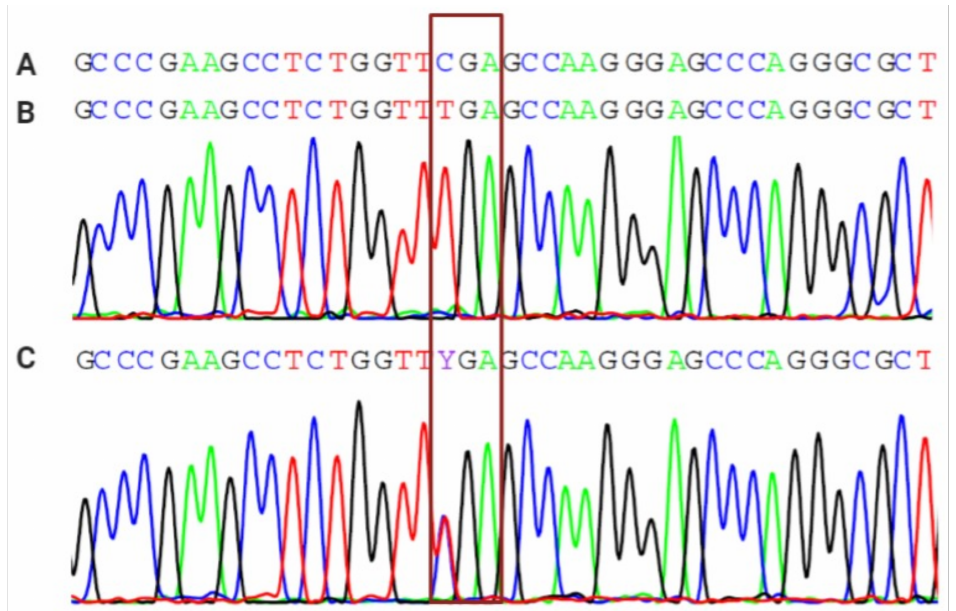
Figure 1. Sequencing analysis for the R257X (c.769C > T) mutation in AIRE gene: ( A ) Healthy homozygote. ( B ) Homozygote for R257Xmutation with c.769C > T conversion. ( C ) Heterozygote for R257Xmutation with c.769C > T conversion in one allele.